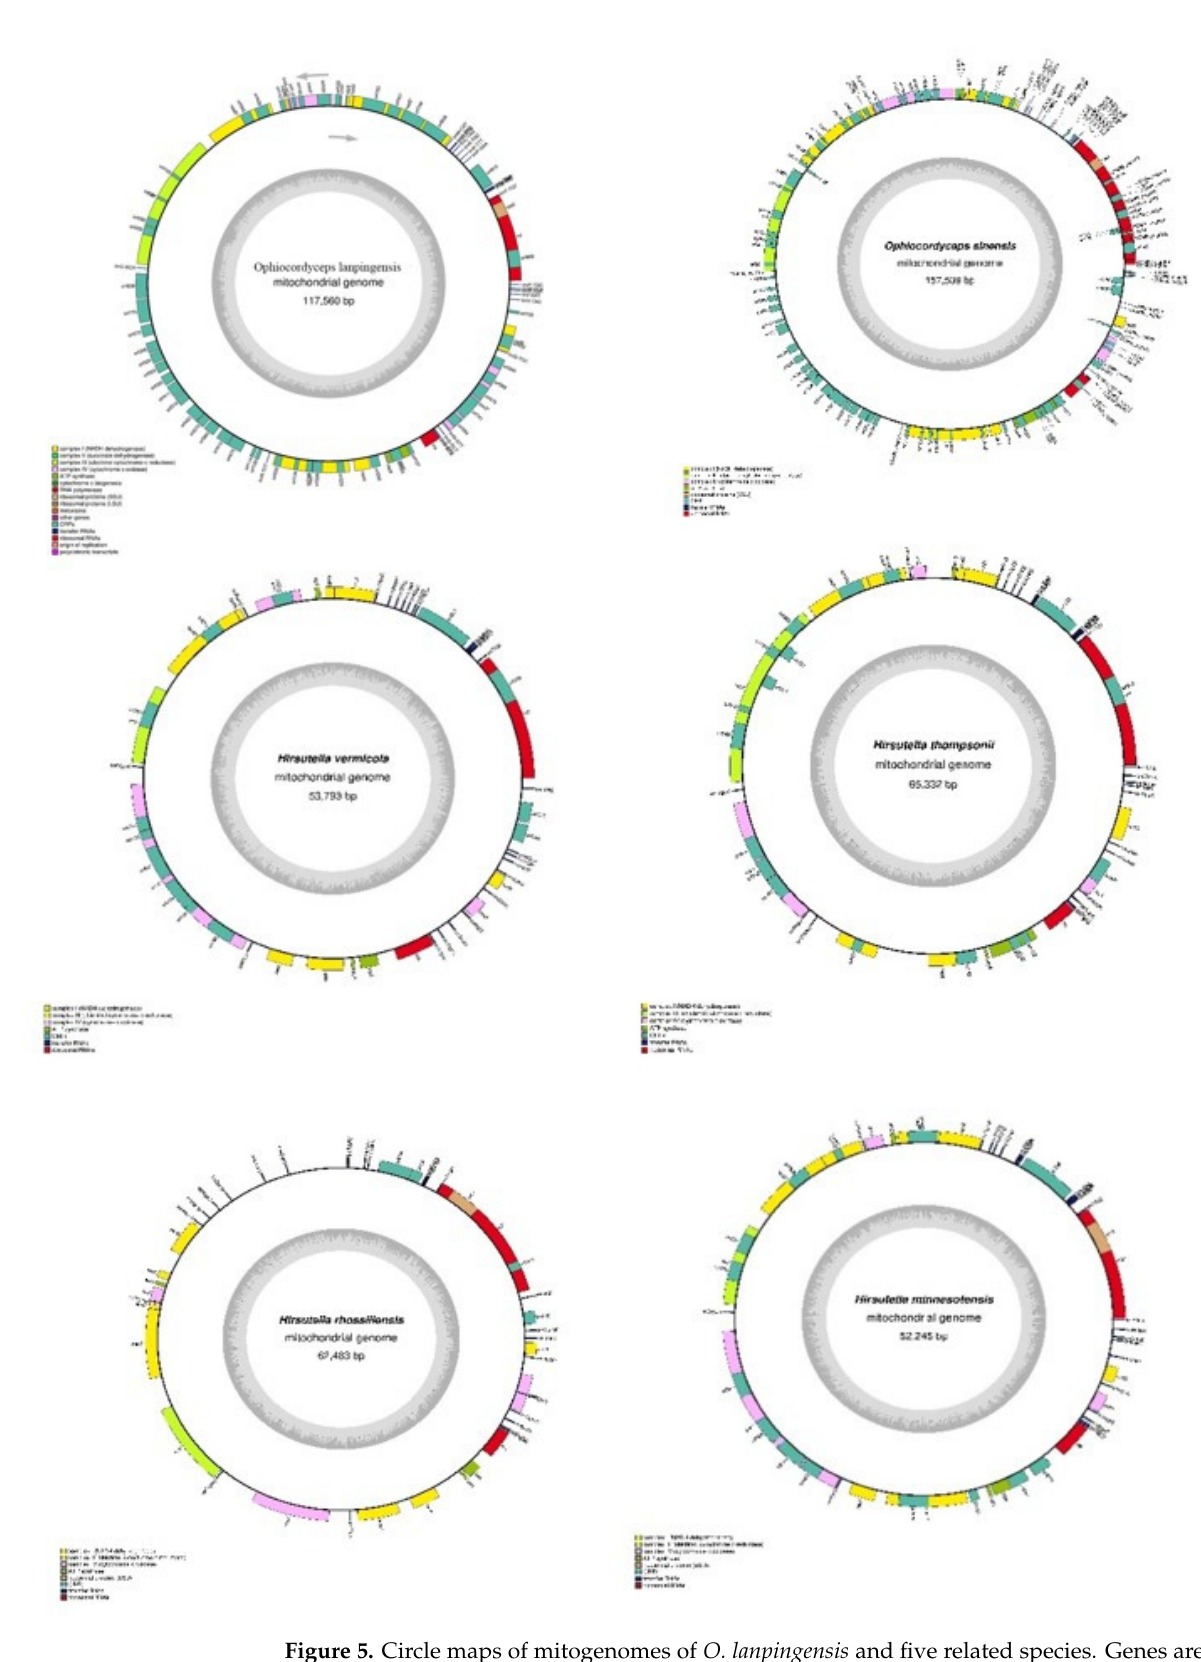
Figure 5. Circle maps of mitogenomes of O. lanpingensis and five related species. Genes are repre- sented by differently colored blocks, as indicated in the legend below the maps.